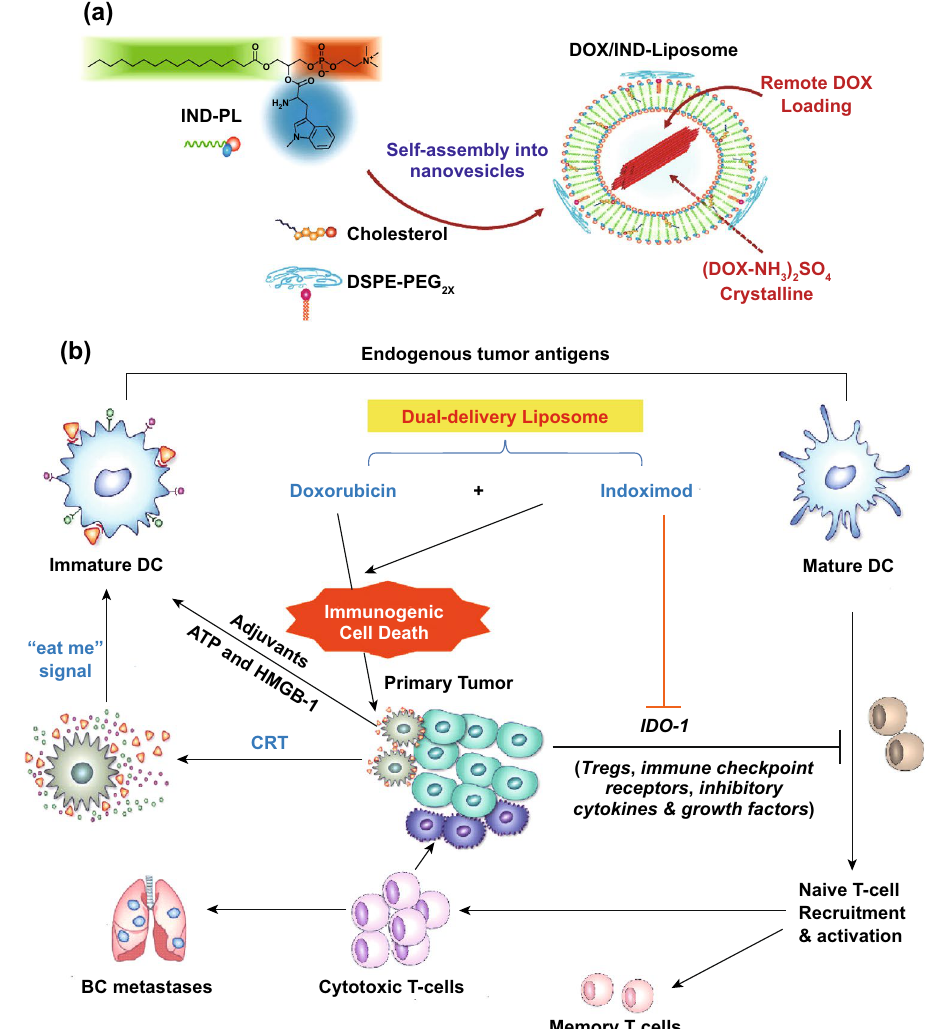
Fig. 3 a Synthesis of DOX/IND-liposome, b Illustration of breast cancer immunotherapy by combined delivery of DOX plus IND. Reproduced with permission from Ref. [106]. Copyright 2018 American Chemical